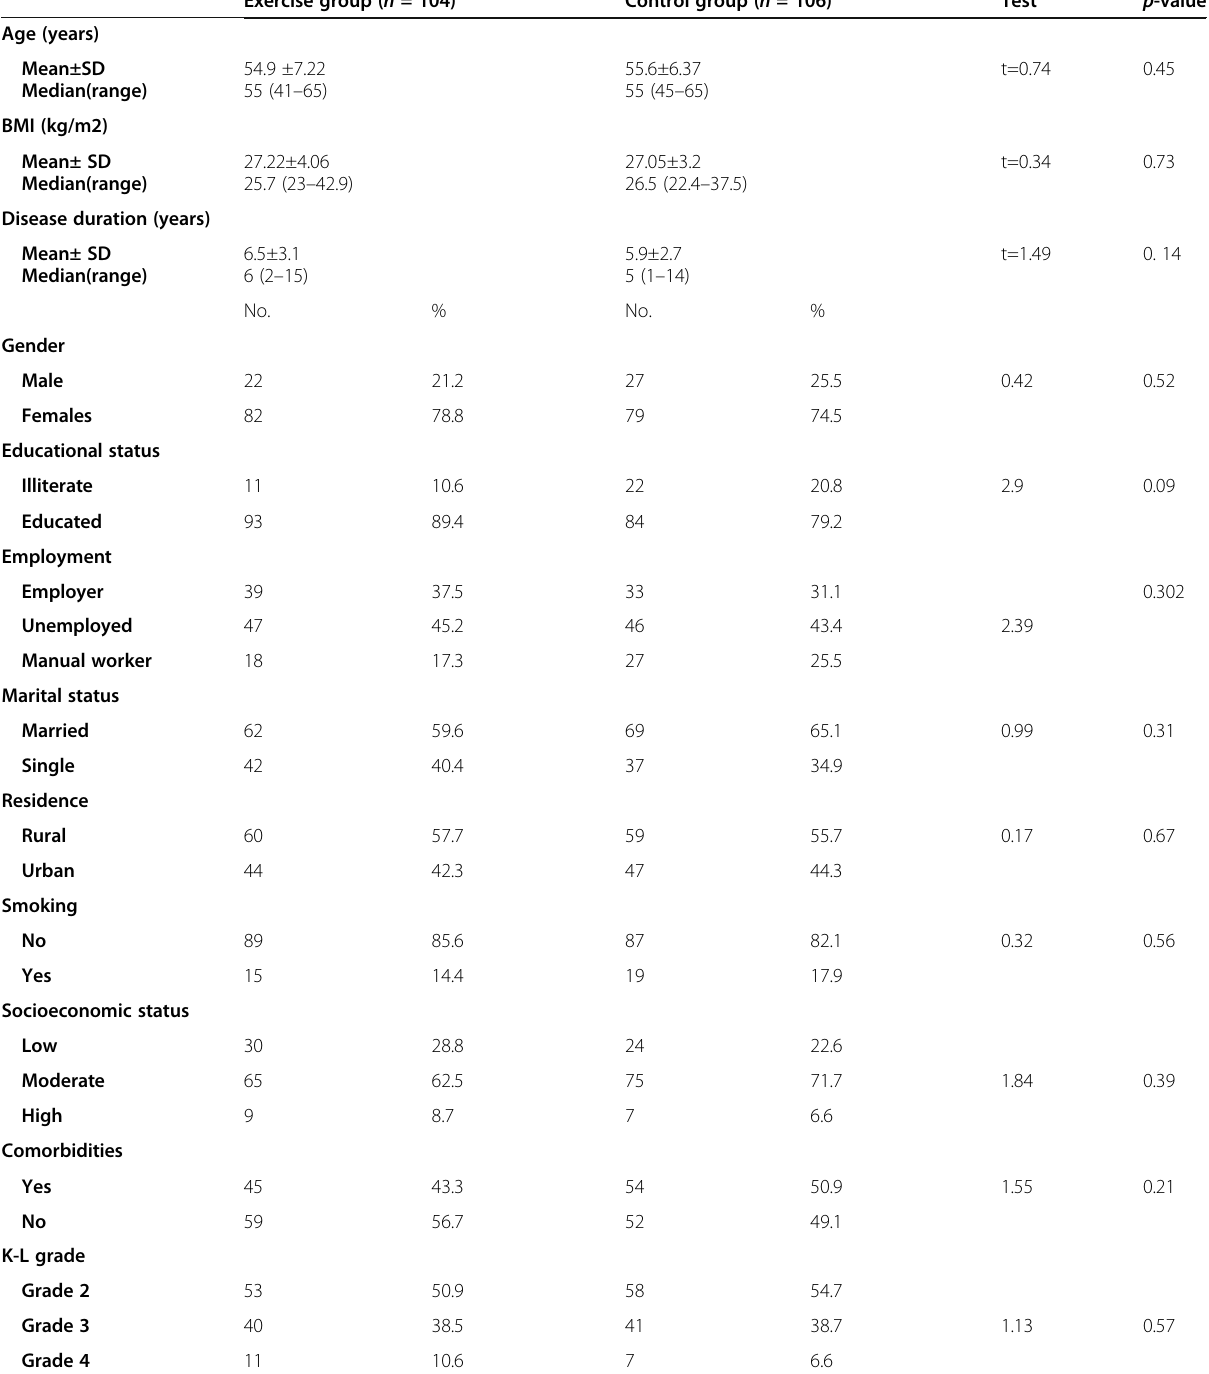
Table 1 Demographic, clinical, and radiological characteristics of the studied groups Exercise group ( n = 104) Control group ( n = 106) Test p